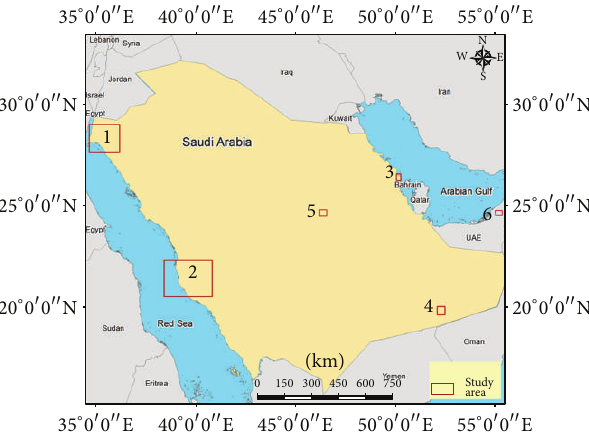
Figure1:MapofSaudiArabiaincludingthefourregionsconsidered in this study represented by the cities of Tabuk, Mecca, and Dhahran and Rub al Khali (Empty Quarter) Desert. AERONET Solar Village and MASDAR locations are indicated by 5 and